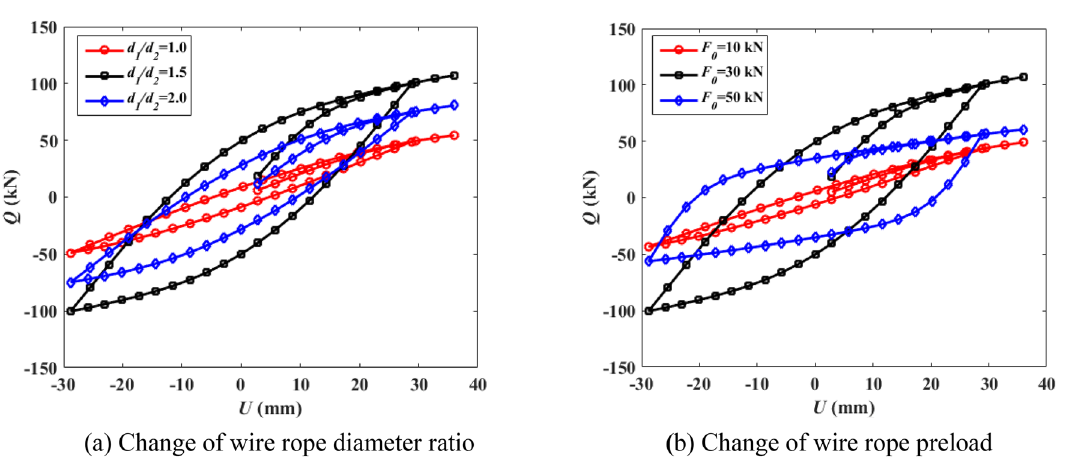
Figure 4. Finite element model of vibration reduction system.